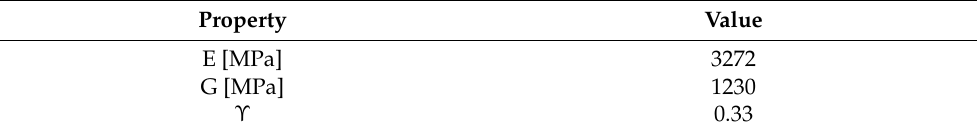
Table 3. Adhesive mechanical